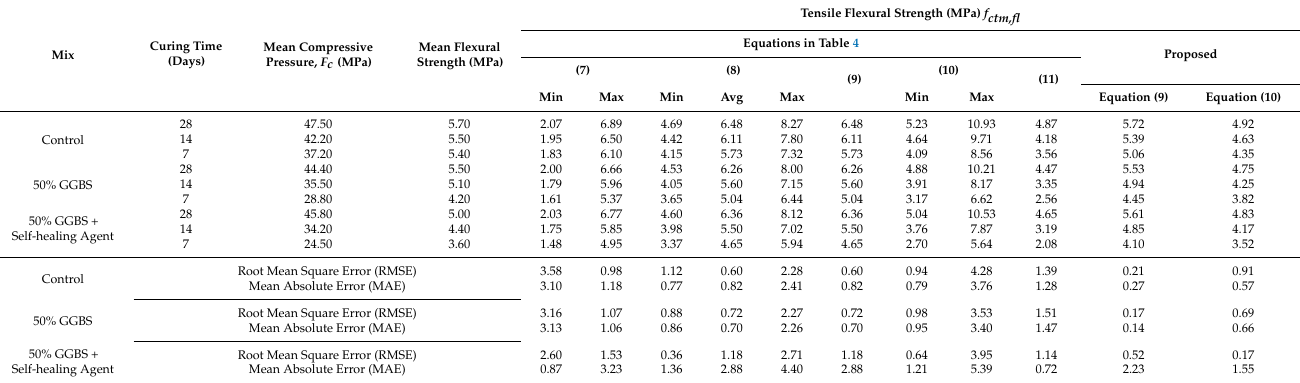
Table 12. Relationship between Compressive strength and Tensile flexural